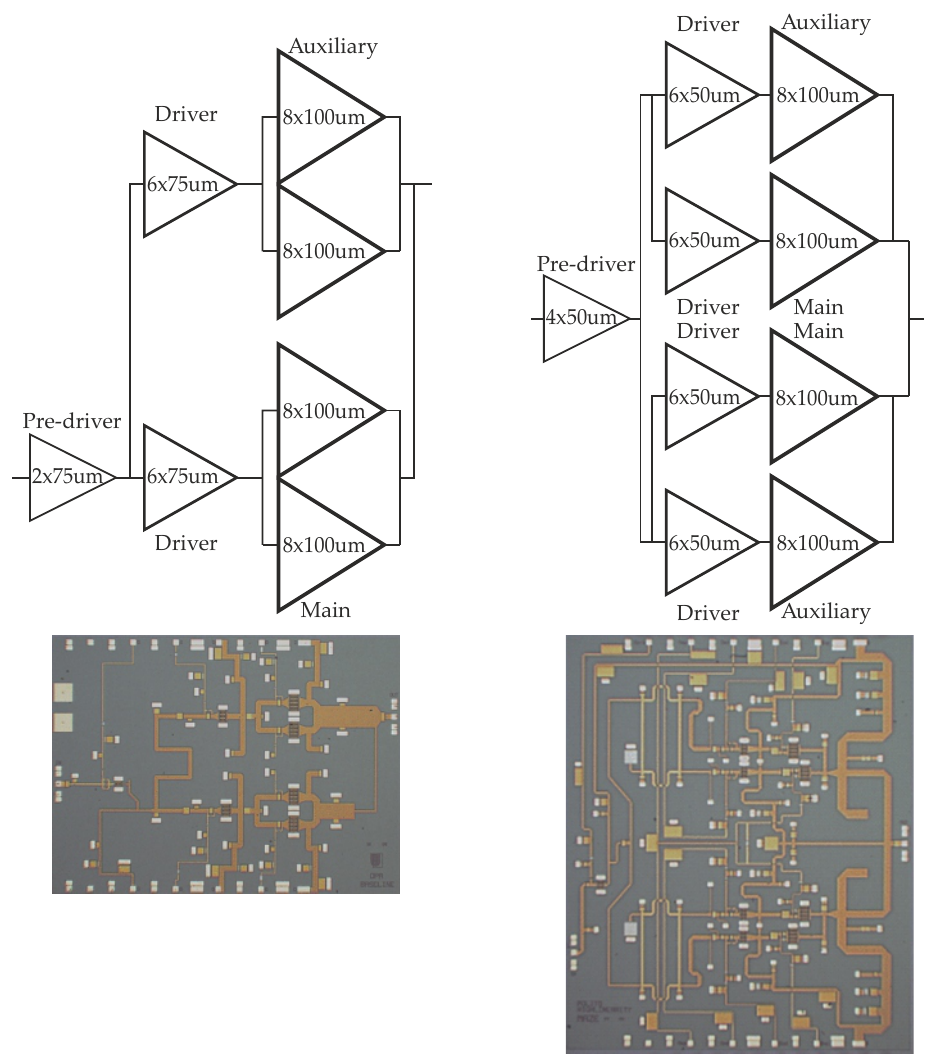
Figure 2. Block diagrams (top) and chip photographs (bottom) of the DPAs in [25]: MMIC1 (left) and MMIC2 (right) c IEEE 2020.